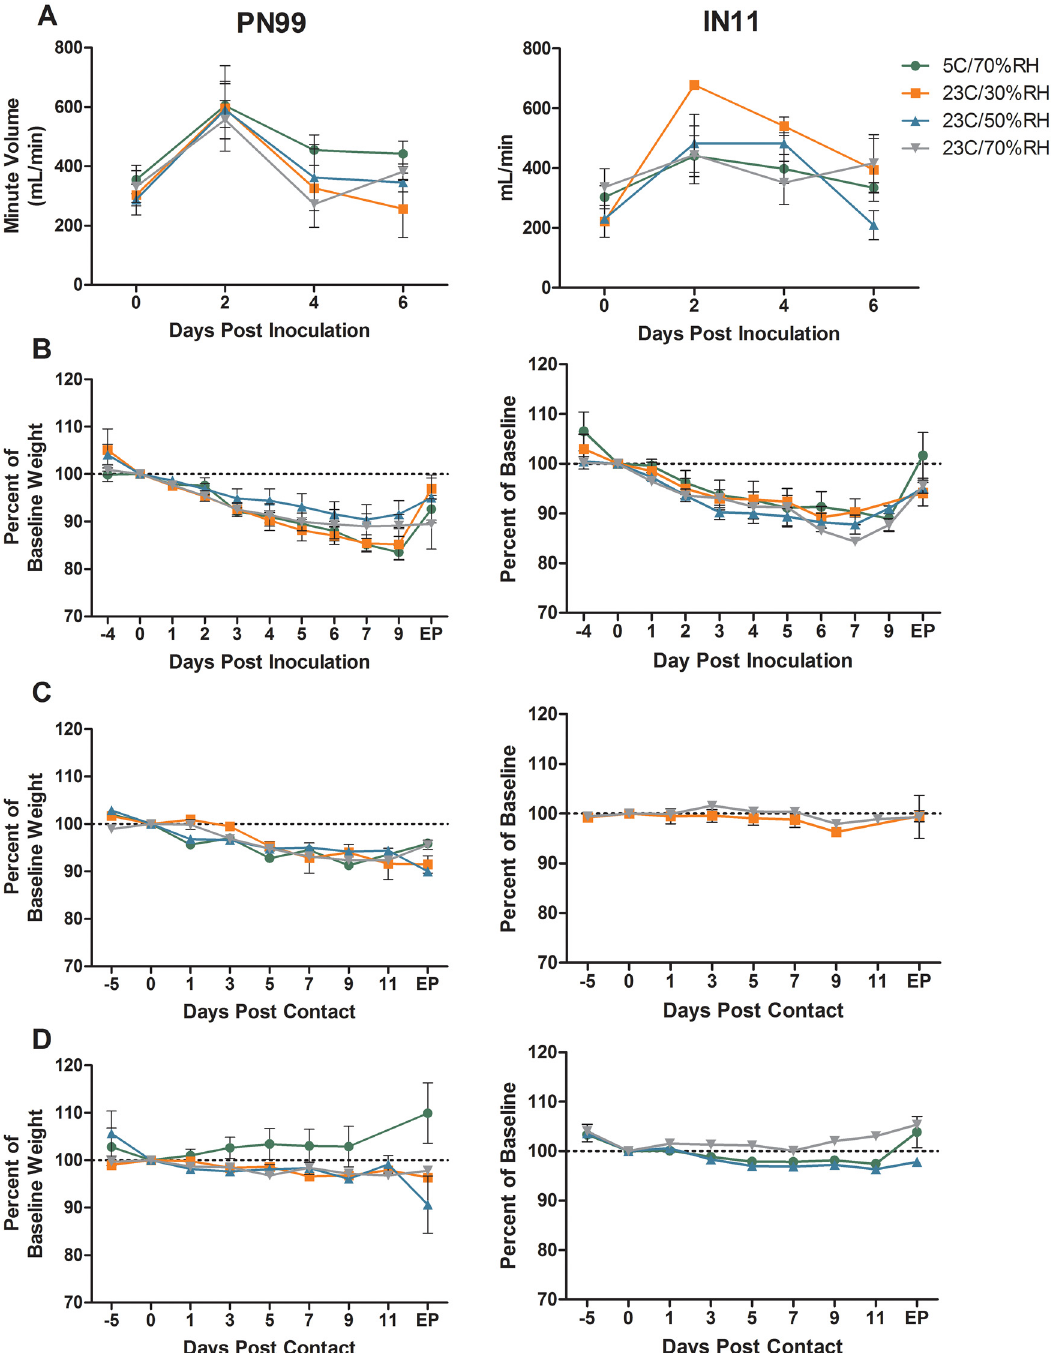
Fig 1. Morbidity observed in influenza virus infected and uninfected ferrets. Six ferrets each were housed under the designated environmental conditions for the purpose of respiratory droplet transmission experimentation. Three ferrets each were presented with 10 3.8 – 10 5.5 pfu of PN99 or IN11 virus by aerosol inhalation and contact ferrets, n = 3, were placed in adjacent cages one day later. Inoculated animals, n = 3, were monitored for changes in minute volume by plethysmography (A) and weight (B) on the days noted. Endpoint (EP) data were collected on days 19 – 29 post inoculation. Both infected (C) and uninfected (D) contact animals were monitored for weight loss. Any contact animal shedding detectable virus in nasal washes and sero-converting to homologous virus was considered infected. EP data were collected on days 18 – 28 post contact. Mean values ± SEM is shown.